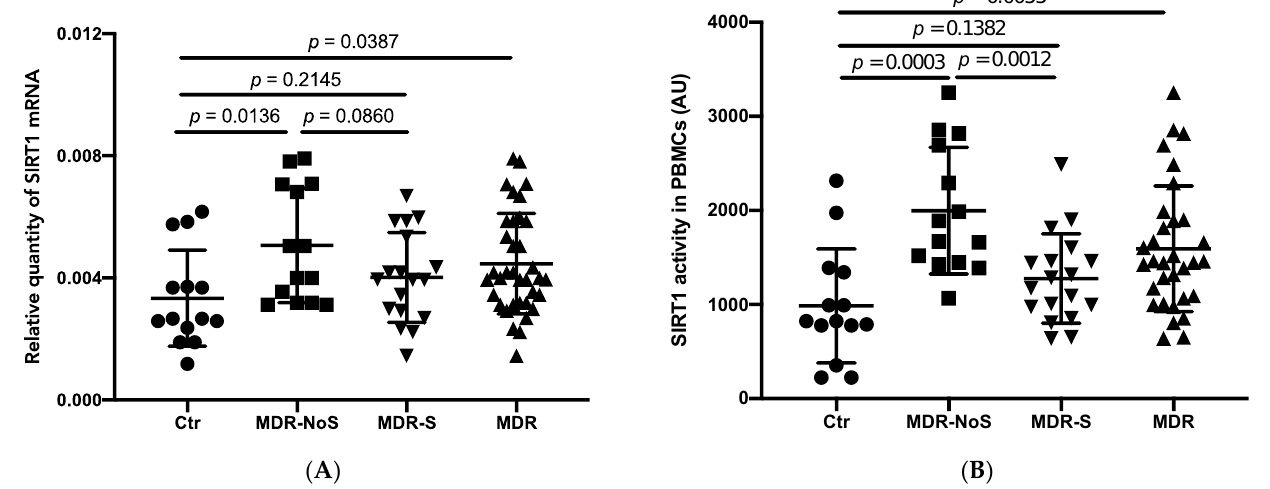
Figure 1 . SIRTUIN 1 (SIRT1) mRNA expression ( A ) and activity ( B ) were measured in peripheral blood mononuclear cells (PBMCs) extracted from sedentary controls (CTR), middle distance runners not taking antioxidant supplements (MDR-NoS), and MDR taking antioxidant supplements (MDR-S). MDR indicates all the MDR, irrespective of antioxidants supplementation. CTR, MDR-NoS, MDR-S, and MDR are respectively indicated with a black circle, black square, black triangle with the vertex at the bottom, and black triangle with the vertex at the top. All data are expressed as mean ± SD.